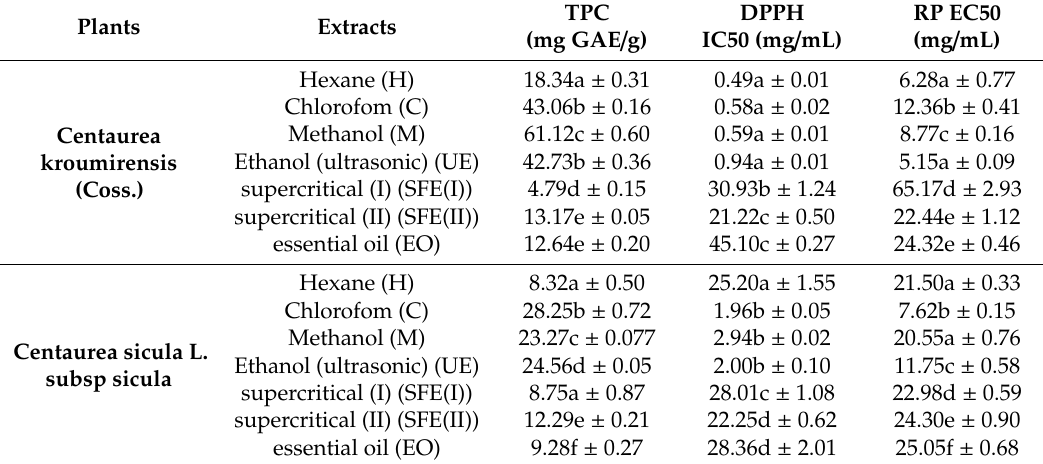
Table 1. Total phenolic, 2,2-Diphenyl-1-picrylhydrazyl hydrate (DPPH) radical scavenging activities and ferric reducing power of Centaurea kroumirensis (Coss.) and Centaurea sicula L. subsp sicula extracts. Values are expressed as means ± SD ( n = 3). Analysis of variance (ONE-way ANOVA) was used for